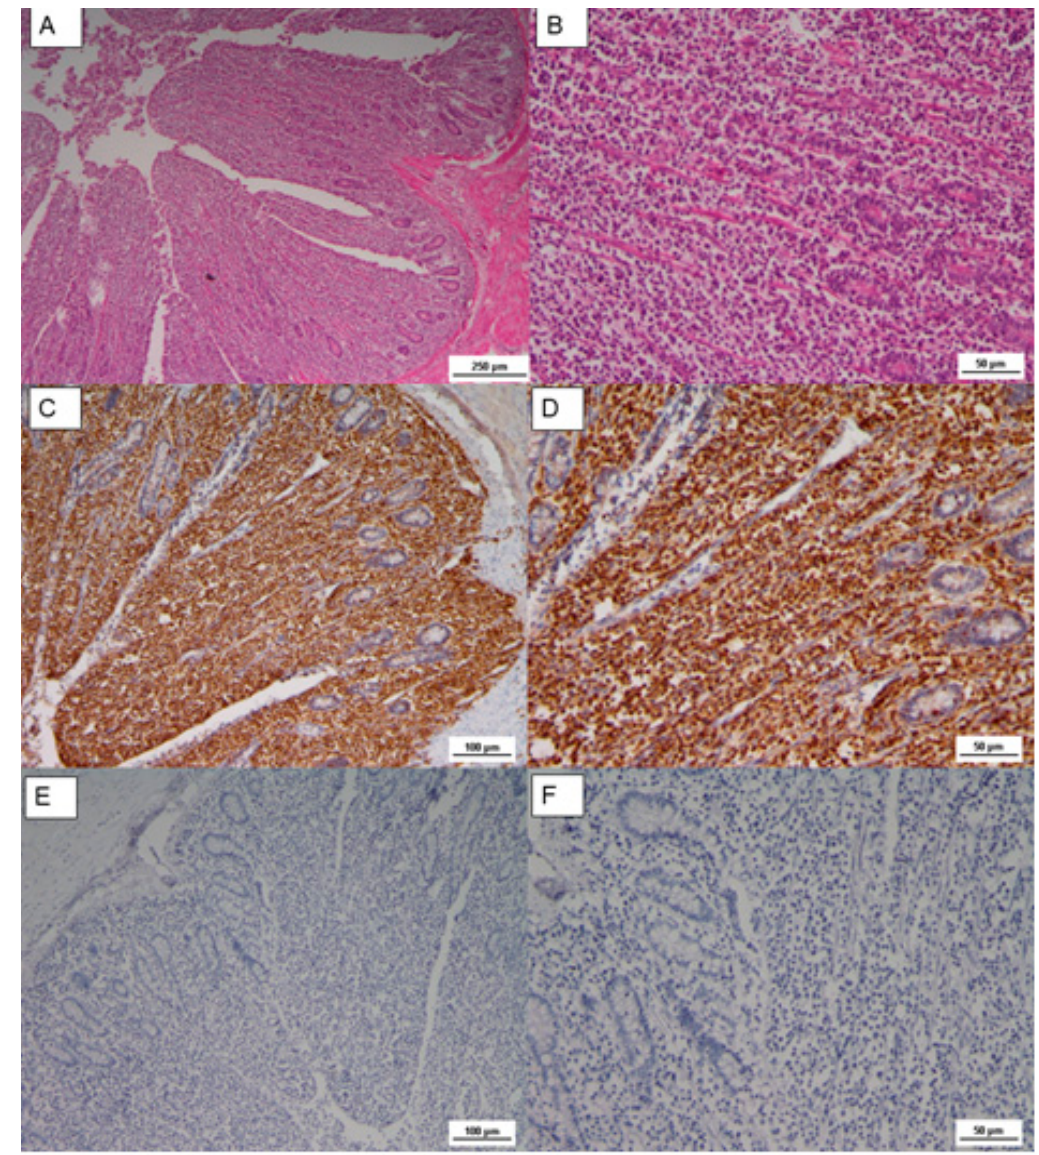
Figure 3. ( A ) Microscopic lesion of cecal tonsils, loss of intestine structure, caused by neoplastic proliferation and massive infiltration of lamina propria, HE, Scale bar = 250 μ m; ( B ) Lymphoblasts with pleomorphic nuclei, and small to medium in size lymphocytes, HE Scale bar = 50 μ m; ( C ) IHC CD3, diffuse positive staining, Scale bar = 100 μ m; ( D ) IHC CD3 Scale bar= 50 μ m; ( E ) IHC CD20, negative staining, Scale bar = 1000 μ m; ( F ) IHC CD20, Scale bar = 50 μ m.